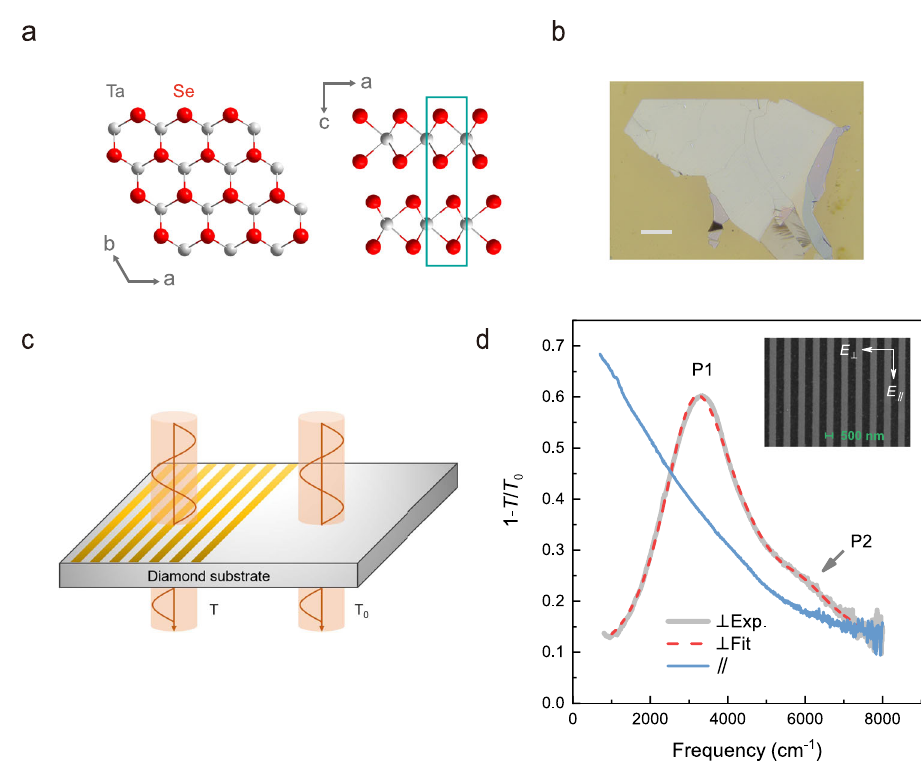
Fig. 1 Characterization of 2H-TaSe 2 ribbon arrays. a The crystal structures of 2H-TaSe 2 viewed along c -axis (monolayer) and b -axis directions (bilayer). The gray and red atoms represent tantalum (Ta) and selenium (Se) atoms, respectively, and the cyan rectangle denotes the unit cell. b The optical image of a typical exfoliated TaSe 2 thin fi lm with thickness of 40 nm. The scale bar is 100 μ m. c The schematic of the setup for transmission measurements. The yellow stripes represent TaSe 2 ribbon arrays, T 0 and T correspond to the transmission light of the bare diamond substrate and a ribbon array on the diamond substrate, respectively. d The extinction spectra 1 − T / T 0 for a plasmonic device (sample T1, d = 40 nm, W = 500 nm), the blue and gray solid lines correspond to the light polarization parallel ( ∥ ) and perpendicular ( ⊥ ) to the ribbon direction respectively. The red dashed line is the fi tted curve of the plasmon peak. The fi rst-order (P1) and the second-order (P2) plasmon peaks are denoted. The inset shows the scanning electron microscopy (SEM) image of the ribbon array.